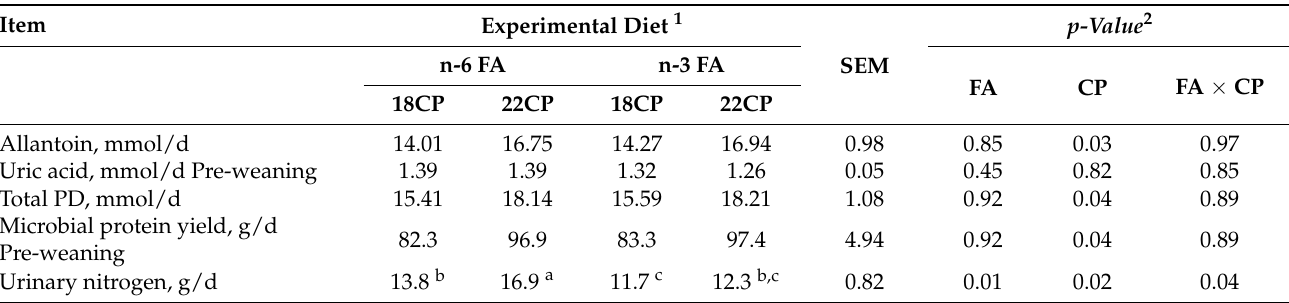
Table 5. Least square means for urinary purine derivatives and microbial protein synthesis in dairy calves fed different FA sources (Ca-salt of n-6 FA source vs. Ca-salt of n-3 FA source) and starter CP content (18 vs. 22%, DM basis) ( n = 10 calves per